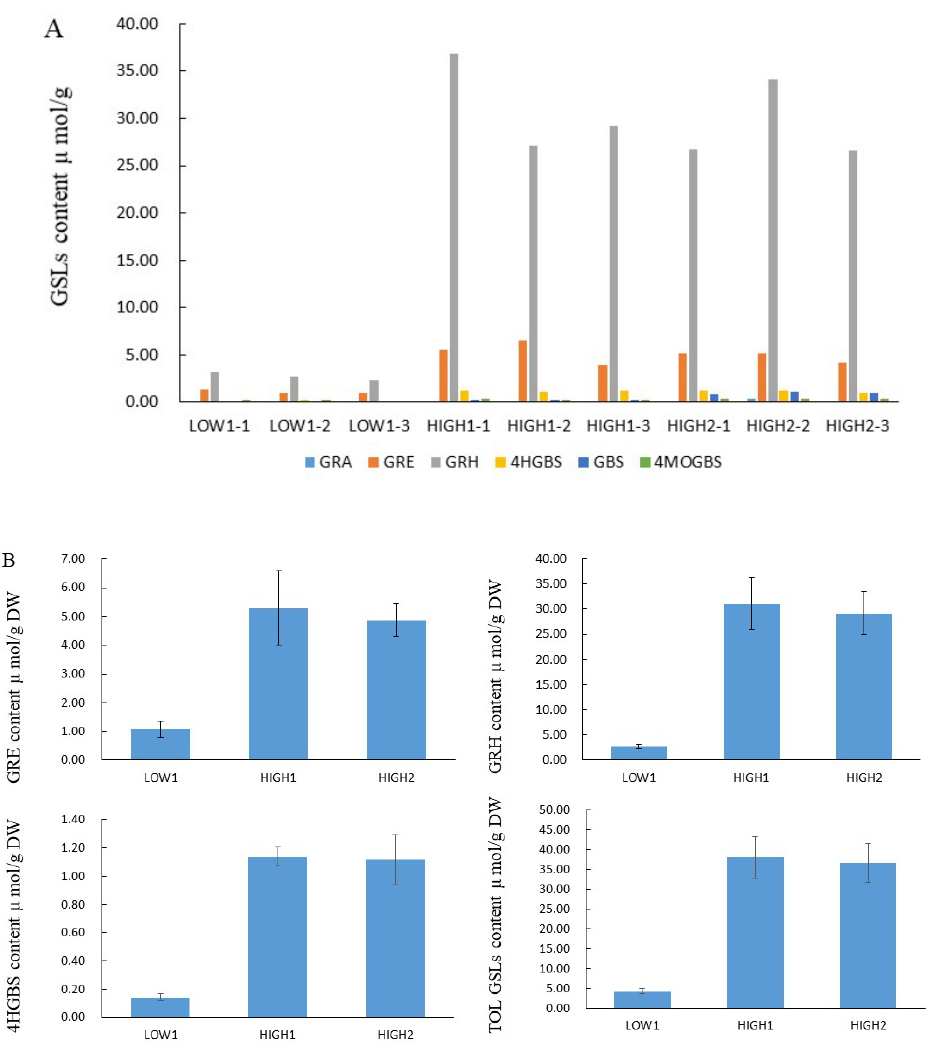
Figure 1. GSL profiles and content of various GSLs in the fleshy taproots of LOW1, HIGH1, and HIGH2 genotypes. ( A ): The x axis shows the GSL profiles of different biological replicates of LOW1, HIGH1, and HIGH2 fleshy taproots. The different color bars indicate GRA, GRE, GRH, 4-hydroxyglucobrassicin (4HGBS), glucobrassicin (GBS), and 4MeO-glucobrassicin (4MOGBS). The y axis shows the content of individual GSLs in LOW1, HIGH1, and HIGH2 fleshy taproots. ( B ): The main GSLs content in radish taproot.